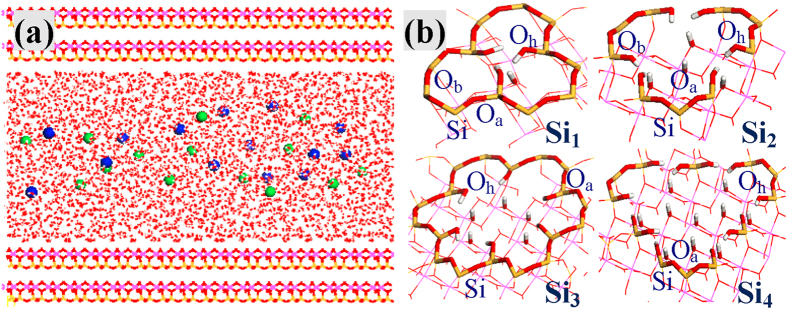
(a) Initial configuration of regular kaolinite in 0.16 mol/L NaCl solutions and (b) local structures of the various defect sites (Si1, Si2, Si3 and Si4) created at the tetrahedral SiO4 surface. The tetrahedral SiO4 and octahedral AlO6 surfaces of kaolinite that have interfacial interactions with salt solutions are situated at the top and bottom, respectively. Oh is from the hydroxyl of silanol, and Oa (bridging O) is also bonded to the silanol Si atom while Ob (bridging O) has no relation with defect sites. Na+ and Cl− ions are represented as blue and green balls, respectively.